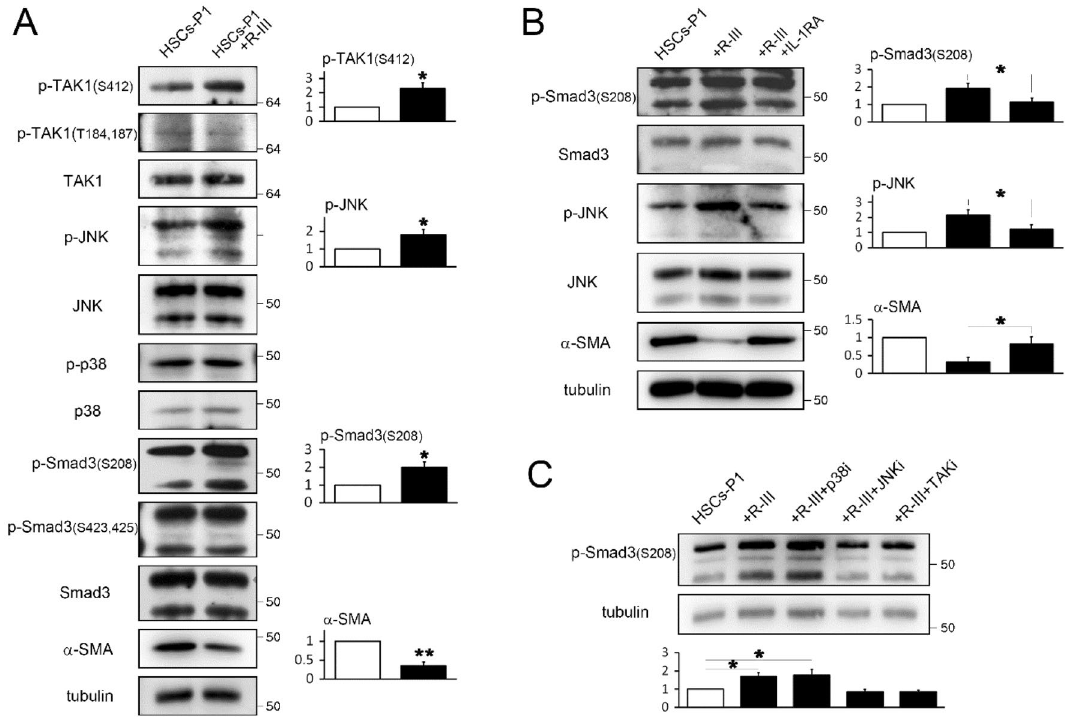
Figure 5. R-III treatment induces the phosphorylation of the Smad3 linker region IL-1β-dependently. ( A ) Hepatic stellate cells after passage 1 (HSCs-P1) were treated with R-III (0.25 μM) for 20 h, and the cell lysates were then analyzed by western blotting. The quantitative densitometric data are presented as mean fold change ± SD of three independent experiments. P -value, paired t -test (compared with untreated cells). * P < 0.05, ** P < 0.01 ( B ) HSCs-P1 were treated with R-III in the presence or absence of interleukin (IL)-1RA (1 μg/mL), and the cell lysates were then analyzed by western blotting. ( C ) HSCs-P1 were treated with R-III in the presence of an inhibitor for TAK1 ((5Z)-7-oxozeaenol, 0.25 μM), p38 (SB203580, 5 μM), or JNK (SP600125, 10 μM), and the cell lysates were then analyzed by western blotting. α-tubulin was used as a loading control. Full-length blots are presented in Supplementary Fig.